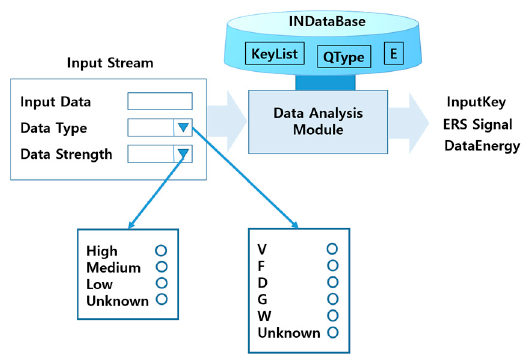
Figure 10. Input Stream Analysis.